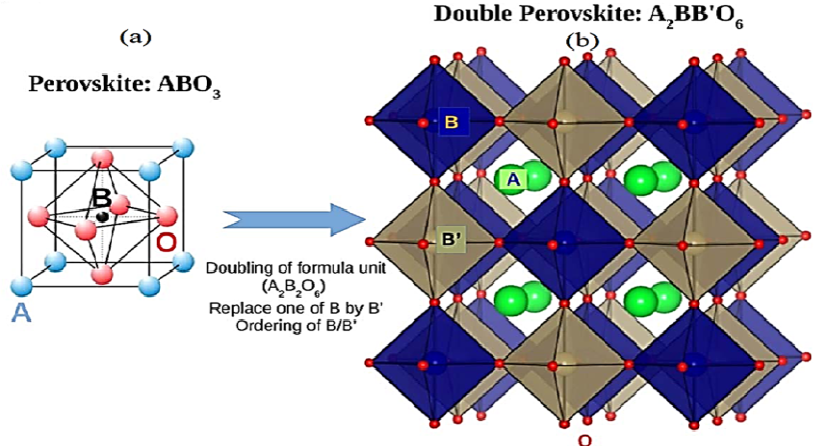
Figure 1. ( a ) Simple perovskite structure ABO 3 ( b ) double perovskite structure A 2 BB ′ O 6.